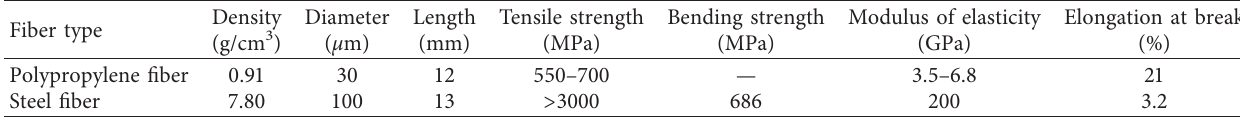
Table 3: Performance index of steel and polypropylene fiber.